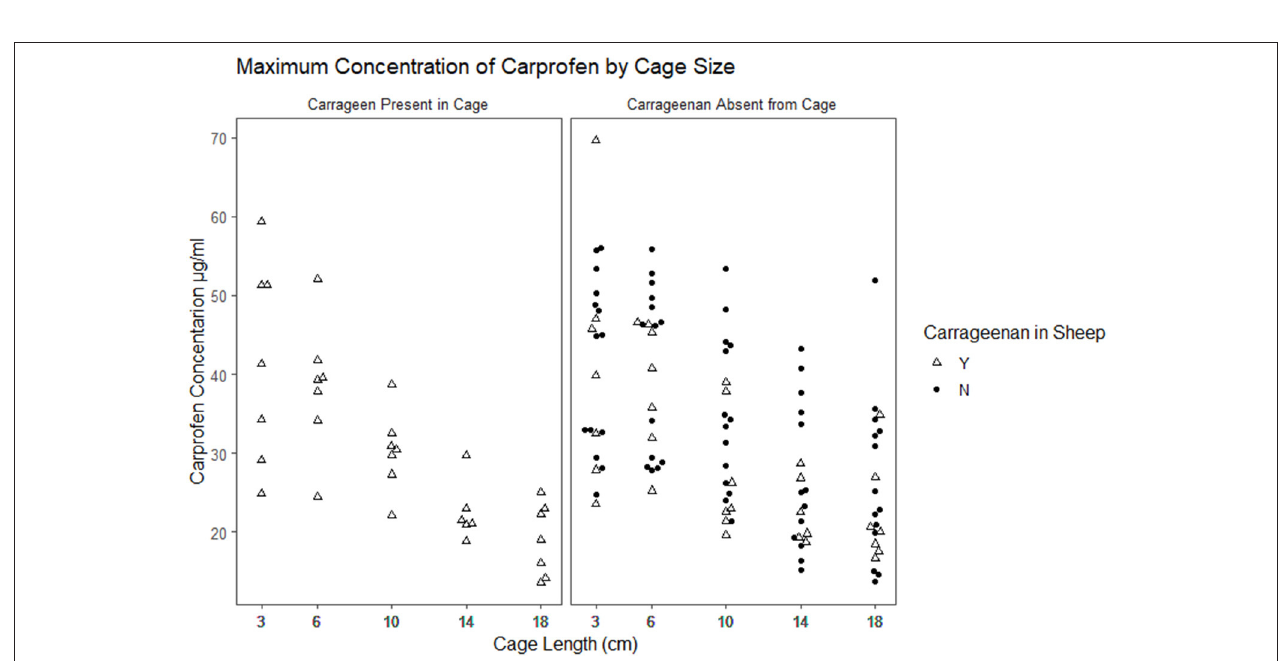
FIGURE 2 | Scatterplot plot of the maximum observed concentration of carprofen by cage size and carrageenan presence within the